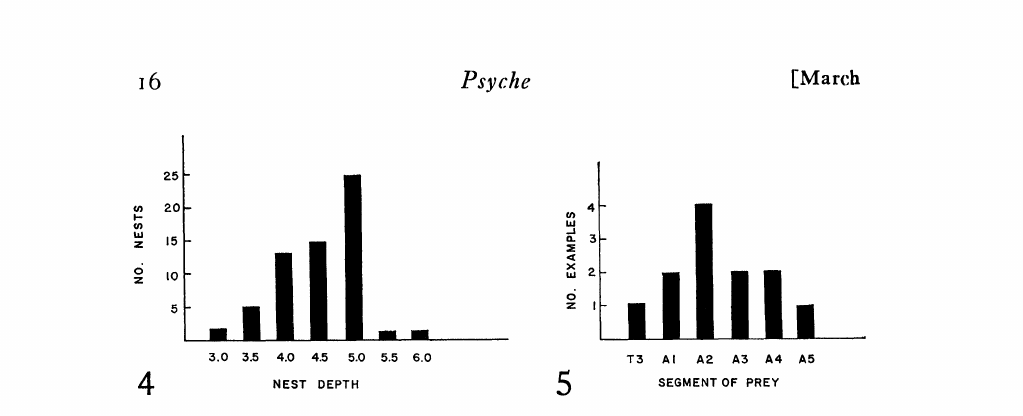
Fig. 4. Number of nests of Ammohila azteca (all Jackson Ho.le, Wyo.) exhibiting various depths (in centimeters). In each case the measurement was ro.unded off to the nearest half cm in the field. Fig. 5. Number of examples of oviposition on various segments of the prey (all Jackson Hole, Wyo.).